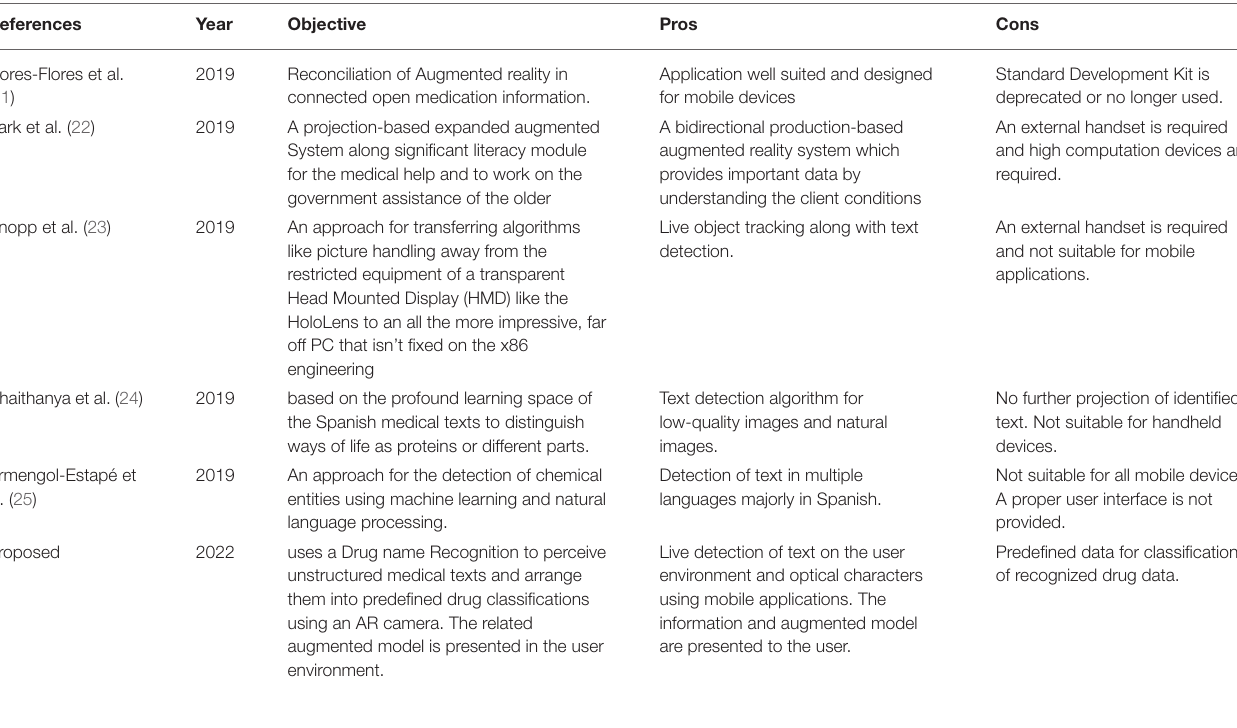
TABLE 1 | Summary of related